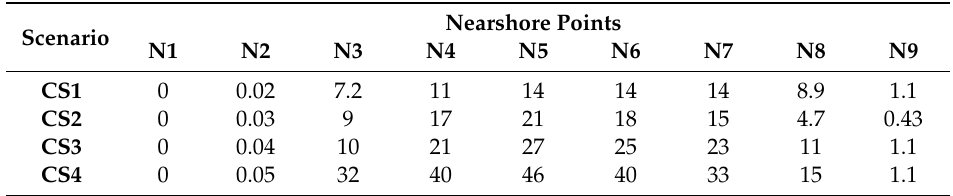
Table 3. Hs variation (%) corresponding to the N-points, considering an energetic summer event (summer A). The results were compared with the no farm